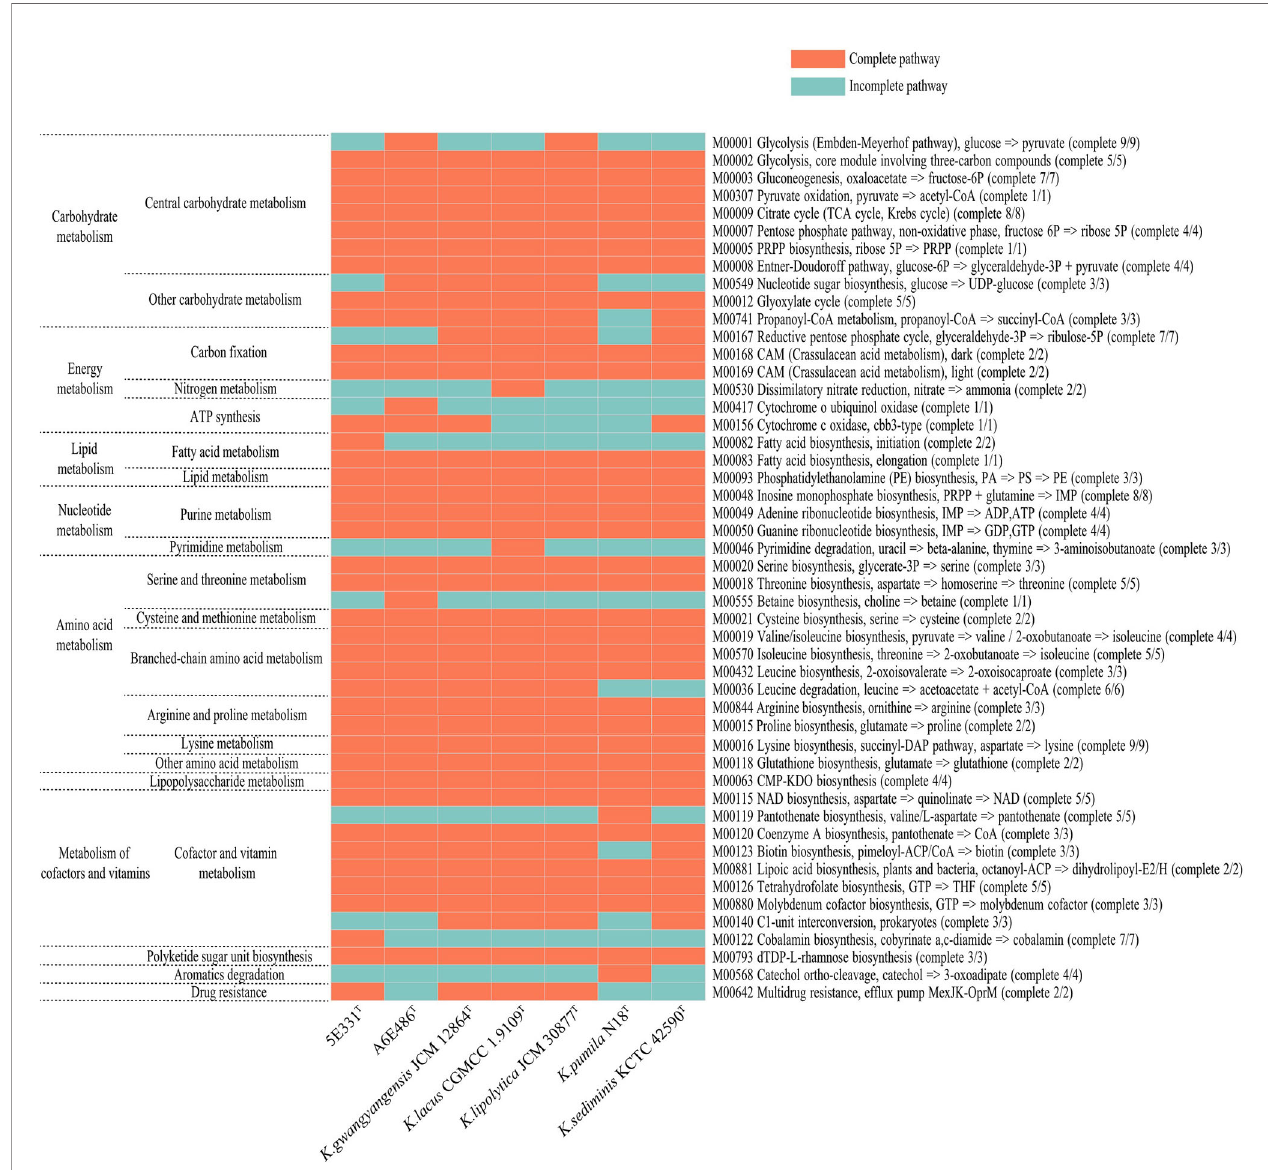
FIGURE 4 | Heat maps of complete and incomplete metabolic pathways in the genomes of strains A6E486 T , 5E331 T , K. gwangyangensis JCM 30877 T , K. lipolytica JCM 12864 T , K. lacus CGMCC 1.9109 T , K. pumila N18 T , and K. sediminis KCTC 42590 T